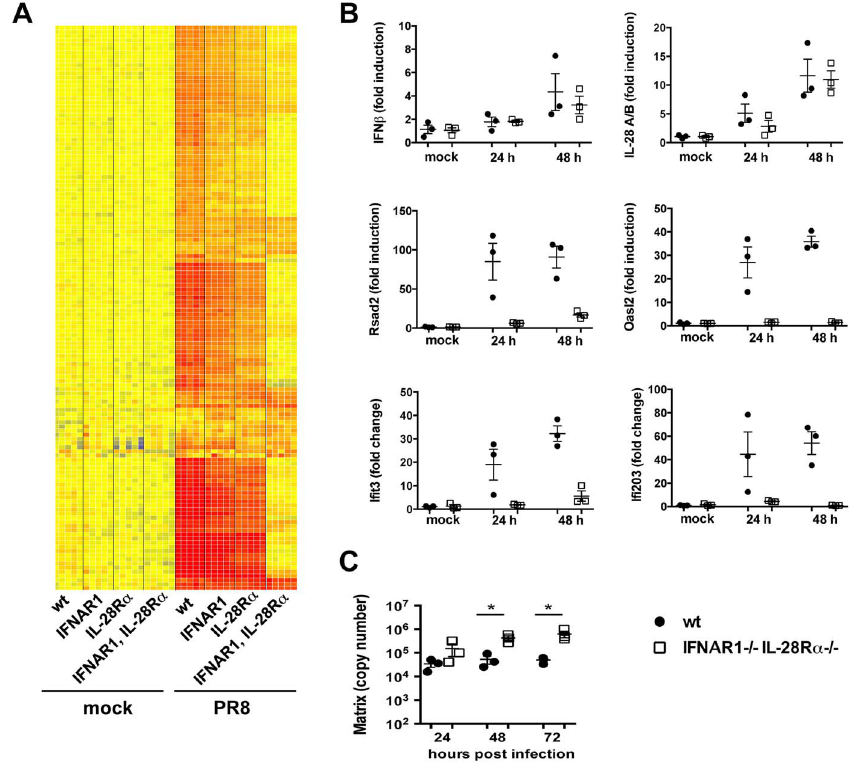
Figure 5. Type I and III are redundant in the MTEC system. (A) Total RNA from mock and PR8 infected cells was analysed using Affymetrix Mouse Genome 430 2.0 microarrays at 24 hpi. Supervised analysis was performed using statistical filtering ( $ 4-fold change relative to mock infected wild-type in at least one treatment group; 2-way ANOVA, p , 0.01, Benjamini-Hochberg multiple test correction). (A) Heat map of the upregulated genes. (B) Quantitative RT-PCR analysis of RNA samples extracted from mock and PR8 infected wild-type and IFNAR1 2 / 2 IL-28R a 2 / 2 double knock-out MTEC at 24 and 48 hpi. All transcripts were first normalized to HPRT levels and then expressed as fold induction relative to the mean of mock infected controls, + / 2 SEM. (C) Wild-type and IFNAR1 2 / 2 IL-28R a 2 / 2 double knock-out MTEC were infected and RNA samples collected at the indicated time points. Viral replication was measured by qRT-PCR on the Influenza A Matrix gene and expressed as copy number + / 2 SEM. Asterisks indicate differences that are statistically significant (unpaired t test; *, P ,